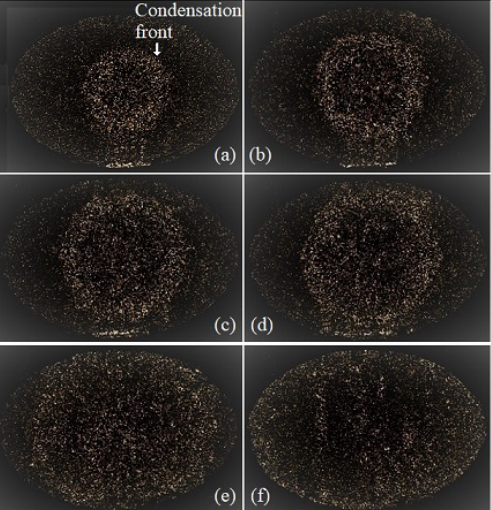
Figure 9. Images of the temporal evolution of the condensation front during the steam injection ( a – f ). The steam is injected at the center of the chamber and it condensates due to the low temperature of the dry porous medium. For short periods of time, the front is mainly radial, but in the lower part, there is also a stream directed towards the recovery hole. In ( a ) it is observed that, the front reaches the vertices of the ellipse too, i.e., it reaches the overall edge of the chamber and is kept there.